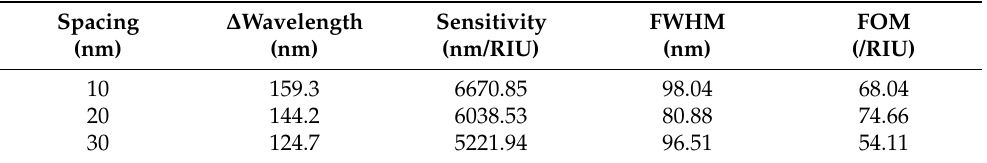
Table 4. Sensitivity, FWHM, and FOM data for different spacings between TiO 2 nanorods of TiO 2 (film)-Au-TiO 2 (nanorods) triple structure SPR